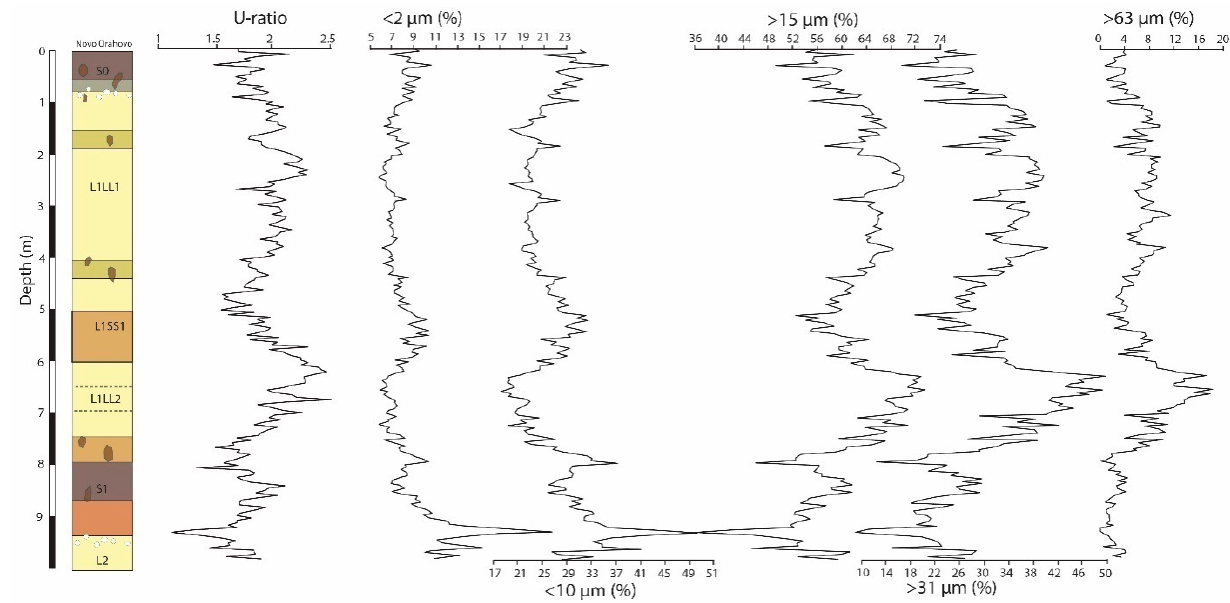
Figure 4. Grain-size variations recorded at the Novo Orahovo loess–paleosol sequence related to pedostratigraphy.